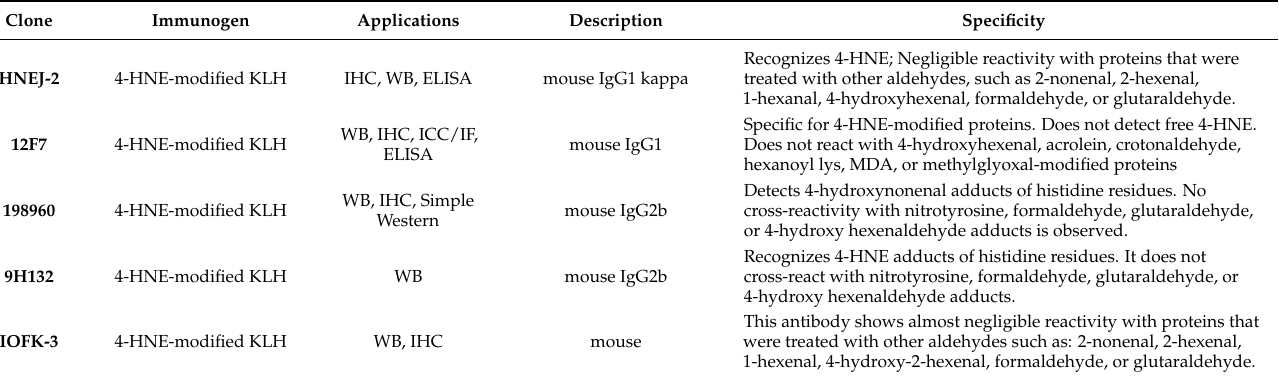
Table 1. Commercially available monoclonal